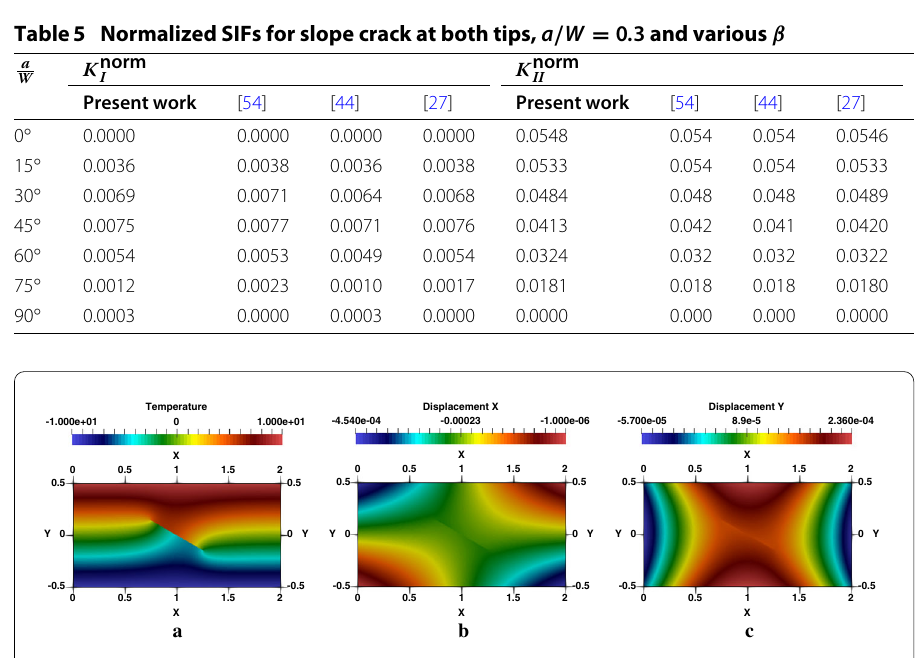
Fig. 8 Rectangular plate with inclined crack, β = 30 ◦ and a / W = 0 . 3: a temperature, b e x -displacement, c e y